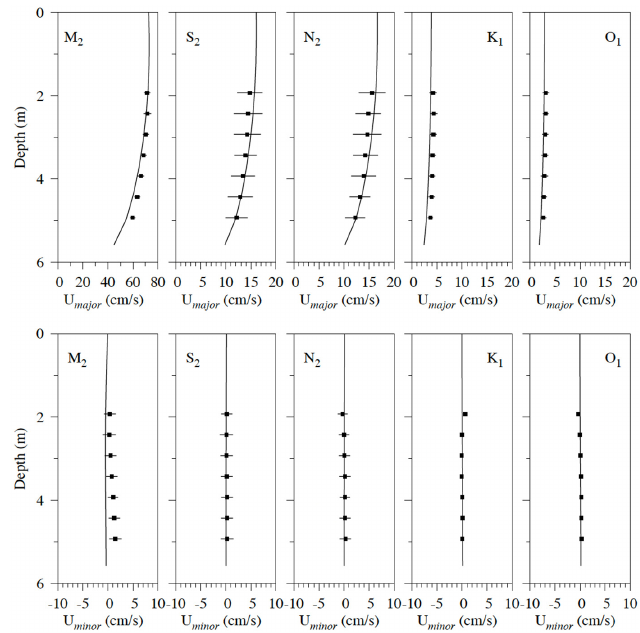
Figure 5. Comparison between model-computed and observed vertical profiles of the major axis, minor axis, orientation, and phase of the M 2 , S 2 , N 2 , K 1 , and O 1 tidal current ellipse at the measurement site B.